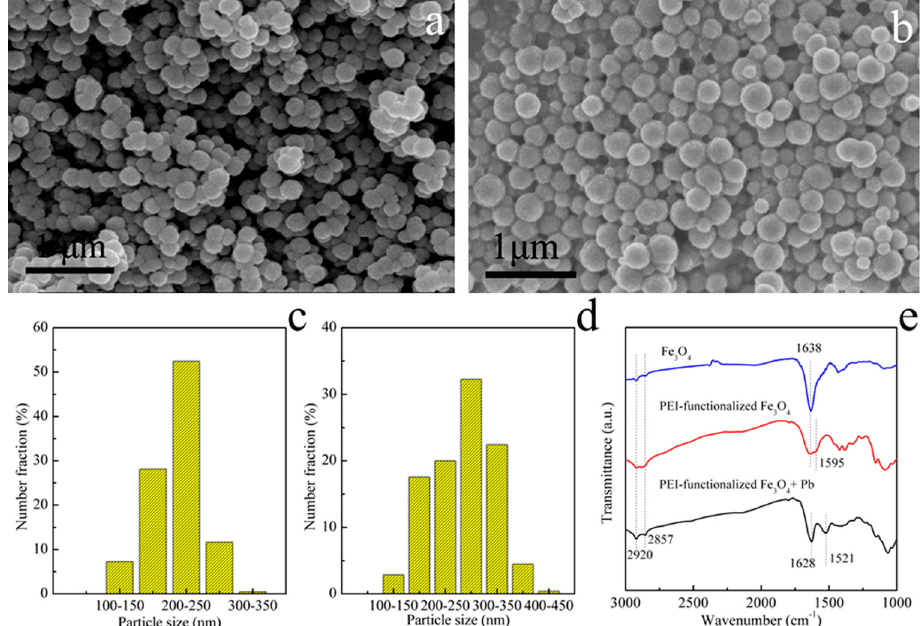
Figure 1. SEM images of PEI-functionalized Fe 3 O 4 MNPs ( a ) and pure Fe 3 O 4 MNPs ( b ), size distributions of PEI-functionalized Fe 3 O 4 MNPs ( c ), and pure Fe 3 O 4 MNPs ( d ), FTIR spectra of pure Fe 3 O 4 MNPs, as well as PEI-functionalized Fe 3 O 4 MNPs before and after Pb(II) adsorption ( e ).